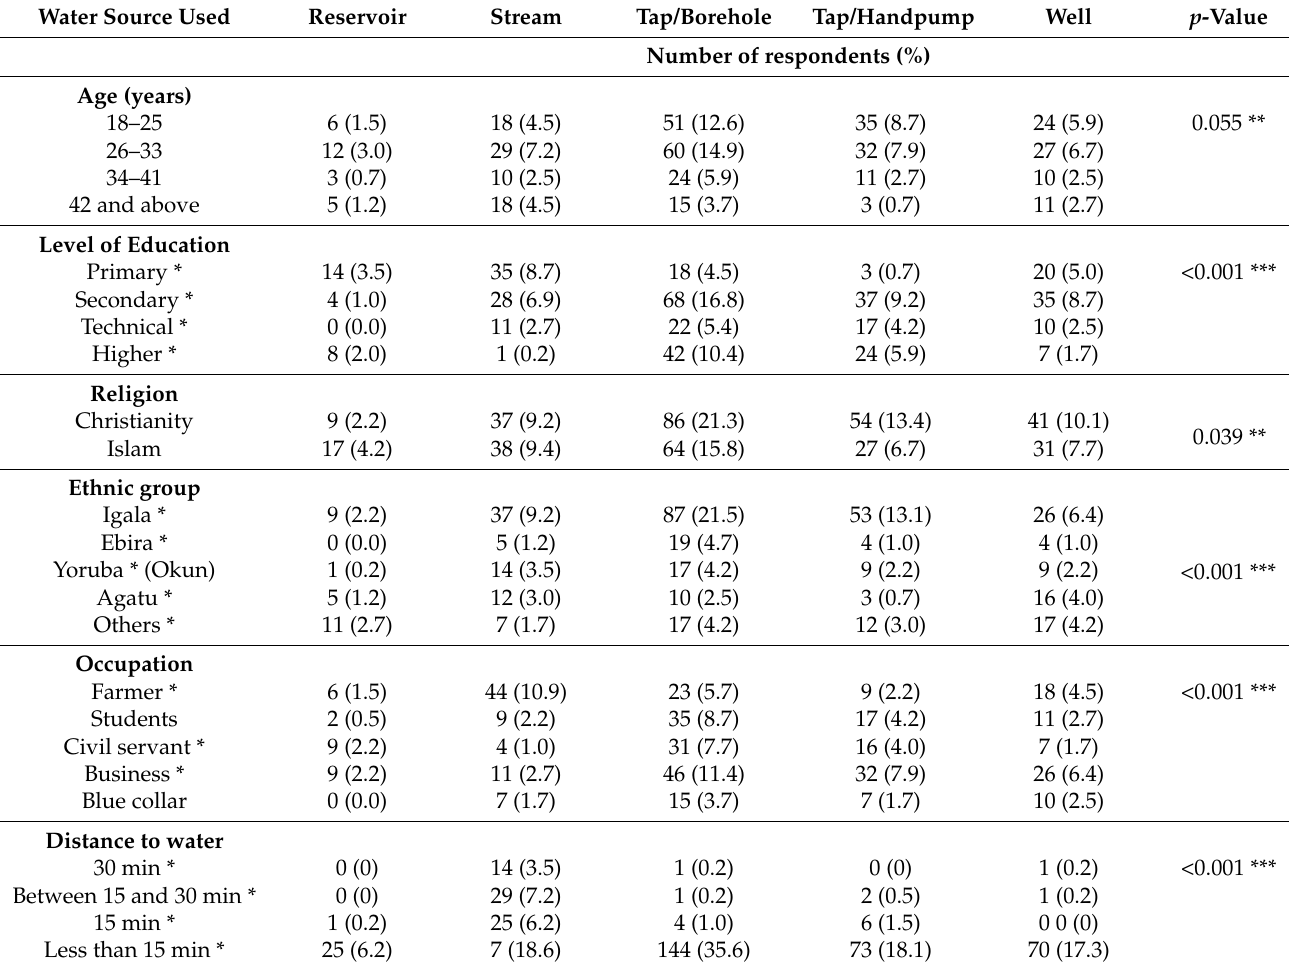
Table 5. Test of association between predictor variables and water source used (N =